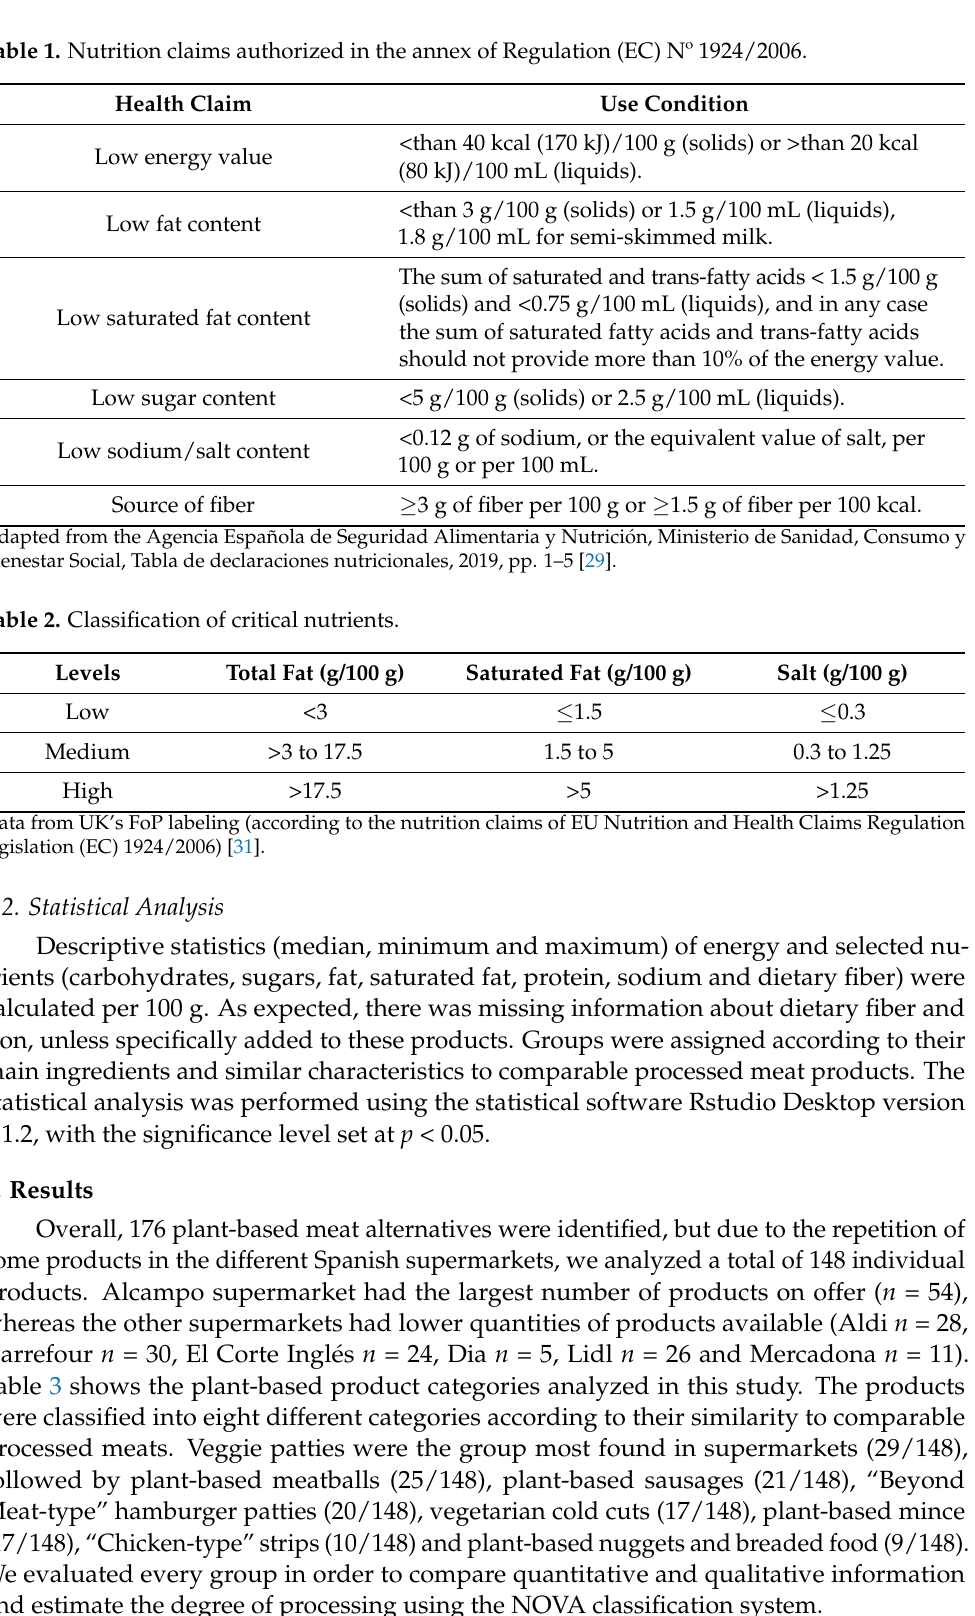
Table 1. Nutrition claims authorized in the annex of Regulation (EC) Nº 1924/2006. Health Claim Use Condition <than 40 kcal (170 kJ)/100 g (solids) or >than 20 kcal Low energy value (80 kJ)/100 mL (liquids).